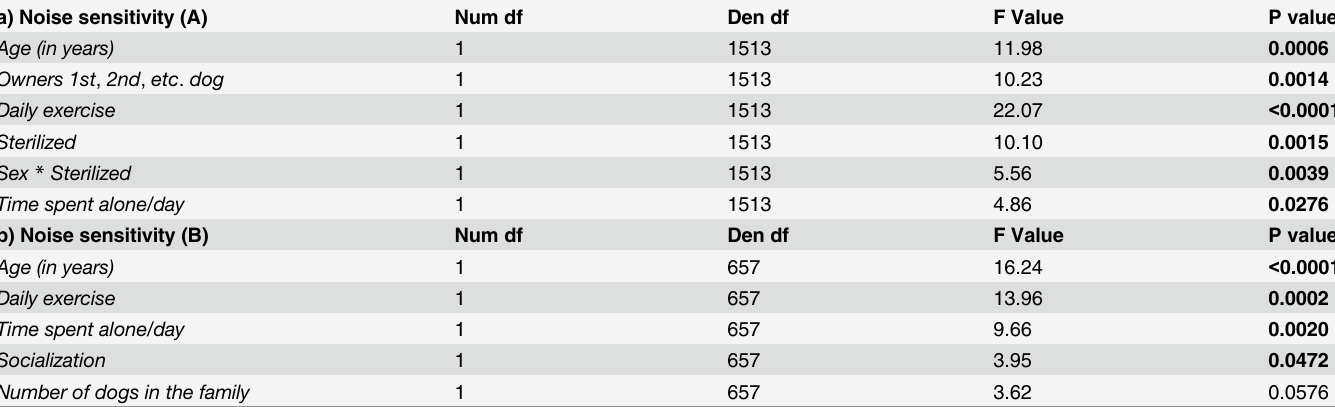
Table 3. Generalized linear mixed model analysis results on the association between environmental factors and noise